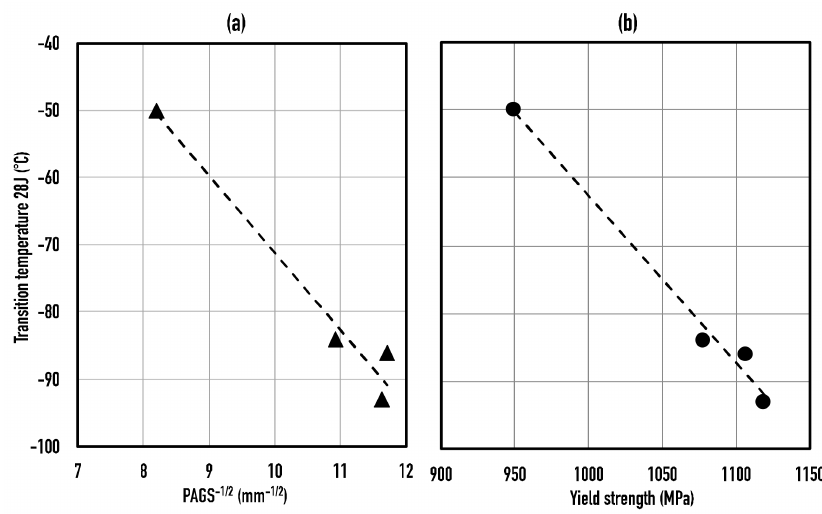
Figure 11. ( a ) Hall–Petch type plot indicating the effect of parent austenite grain size in direct quenched